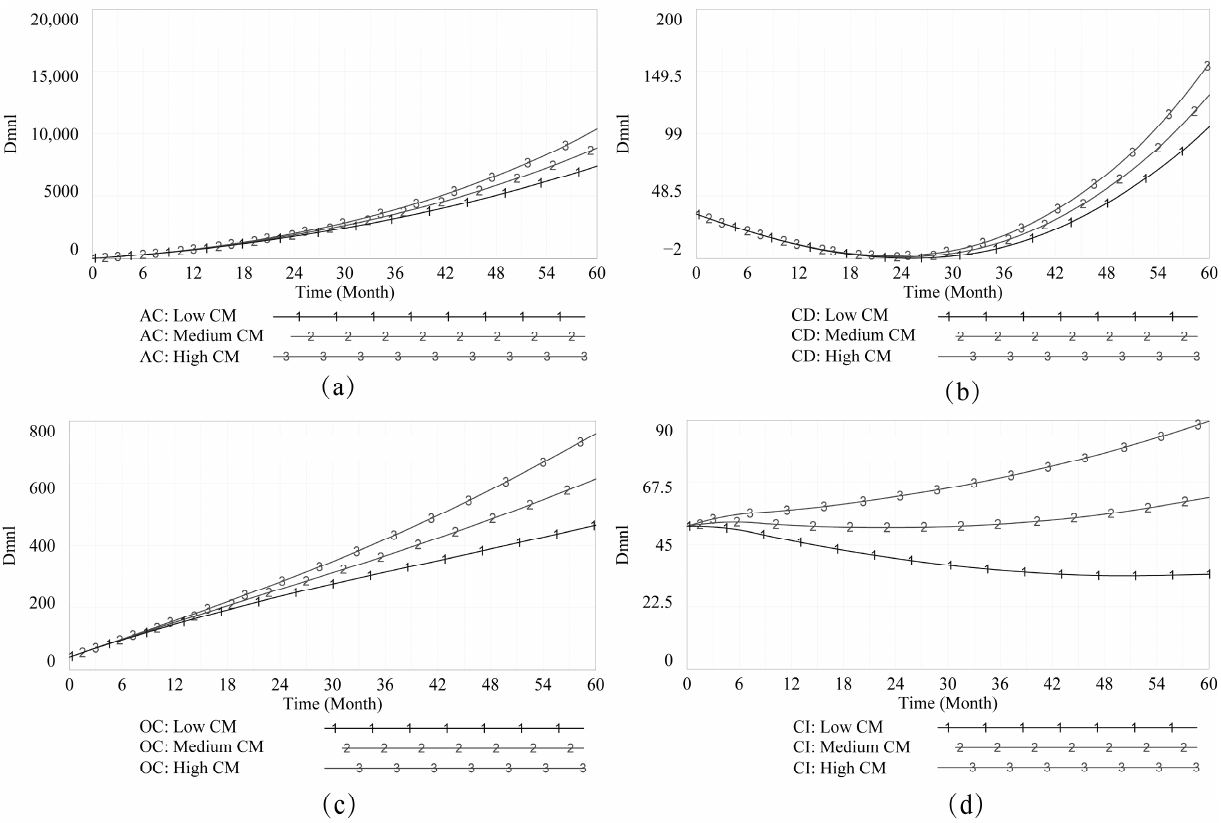
Figure 5. Evolution of cognitive biases and AC under the CM scenarios. Subfigures ( a – d ) illustrate the AC, CD, OC, and CI curves under varied CMs.